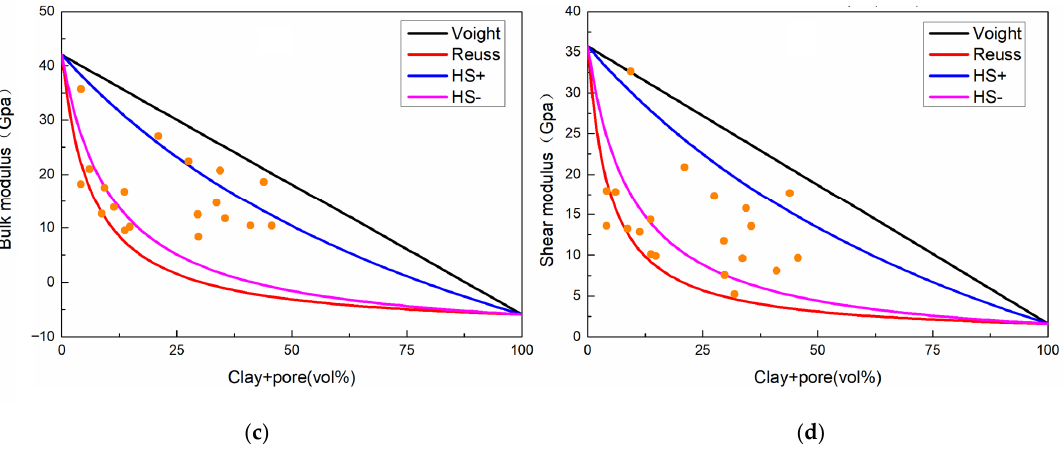
Figure 4. Effects of stiffer and soft materials on the elastic properties of samples, cross-plot of ( a ) bulk modulus and stiffer minerals, ( b ) shear modulus and stiffer minerals, ( c ) bulk modulus and soft materials, and ( d ) shear modulus and soft materials. The solid lines in the figure are the boundary of simulation (the black line is the Voight boundary, the red line is the Reuss boundary, the blue line is the upper limit of Hashin–Shtrikman model, and the pink line is the lower limit of Hashin–Shtrikman). Table 2. Mineral content and porosity of the four